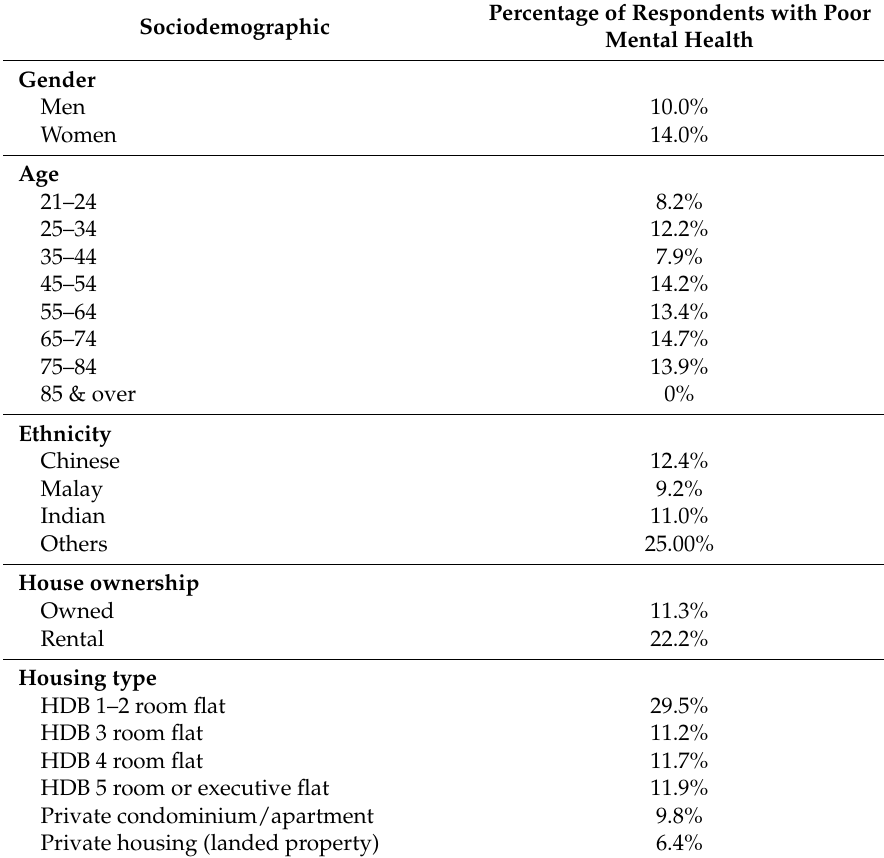
Table 3. Percentage of respondents with poor mental